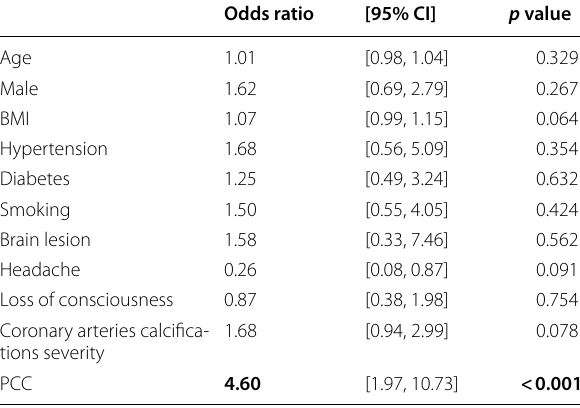
p <0.05 is shown in bold